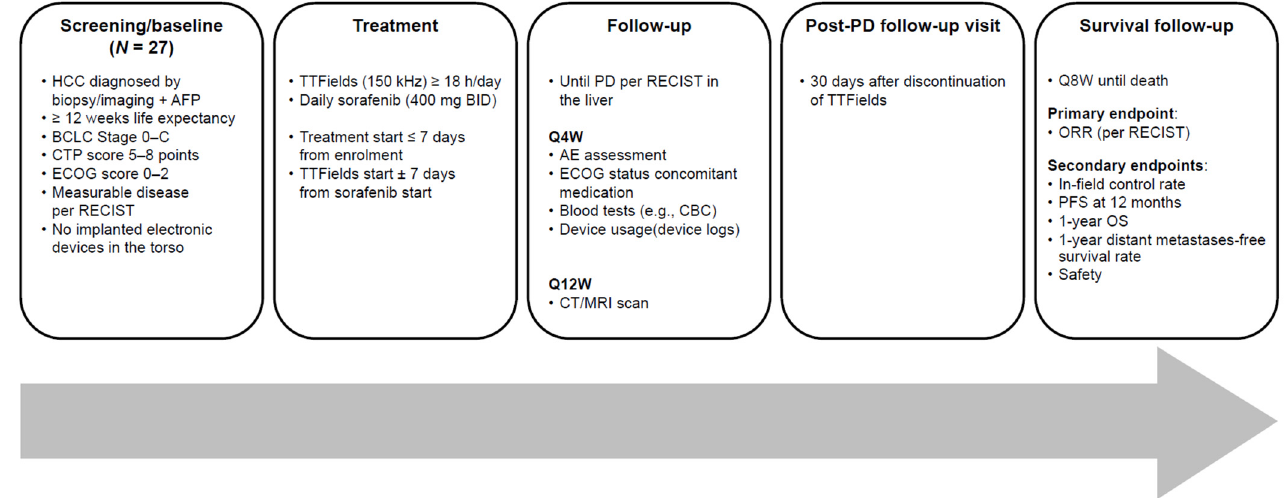
Figure 1. Study design. AE = adverse event; AFP = alfa fetoprotein; BCLC = Barcelona clinic liver cancer staging; BID = twice daily; CBC = complete blood count; CTP = Child–Turcotte–Pugh; CT = computed tomography; ECOG = Eastern Cooperative Oncology Group; HCC = hepatocellular carcinoma; MRI = magnetic resonance imaging; ORR = overall response rate; OS = overall survival; PD = progressive disease; PFS = progression-free survival; Q4W = every four weeks; Q8W = every eight weeks; Q12W = every 12 weeks; RECIST = response evaluation criteria in solid tumors; TTFields = Tumor-Treating Fields.